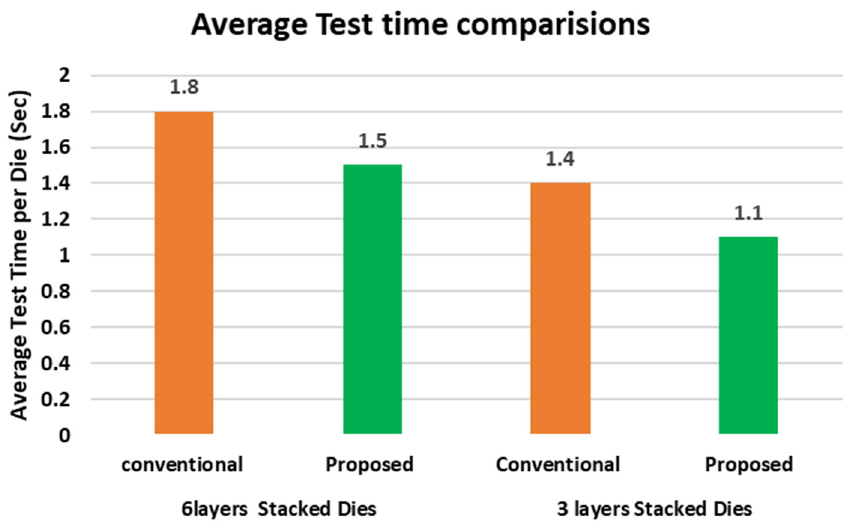
Figure 14. TSV test time Analysis graph between Conventional and Proposed TSV BIST approach.